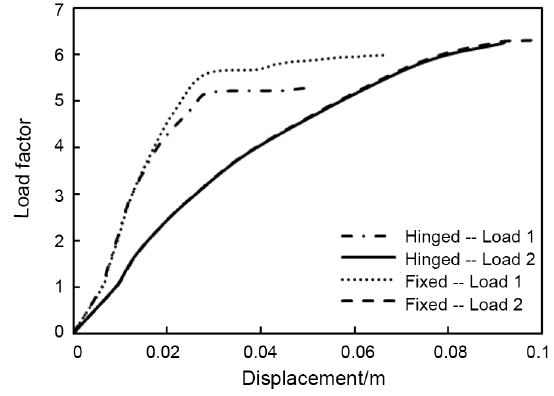
Fig. 17. Load-deflection curves of the hybrid structure with different support